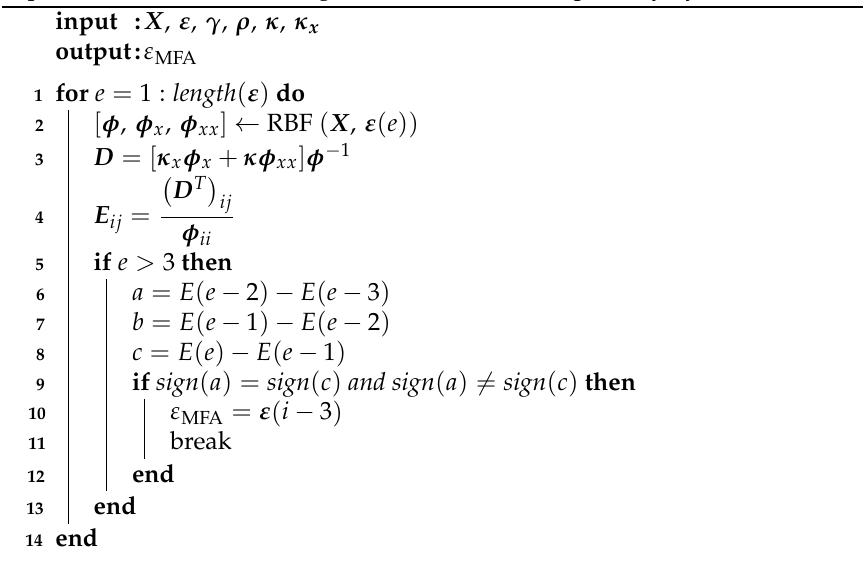
Figure 2. Sample of a graph of the cost function. ε FA is equal to the ε for which the cost function reaches minimum while ε MFA is equal to the ε for which the oscillatory behavior begins. Algorithm 2: Pseudocode describing the proposed modified Fasshauer algo- rithm. X is the vector of collocation points coordinates, ε is a vector of the shape parameter values. The range of ε was selected empirically by trial and